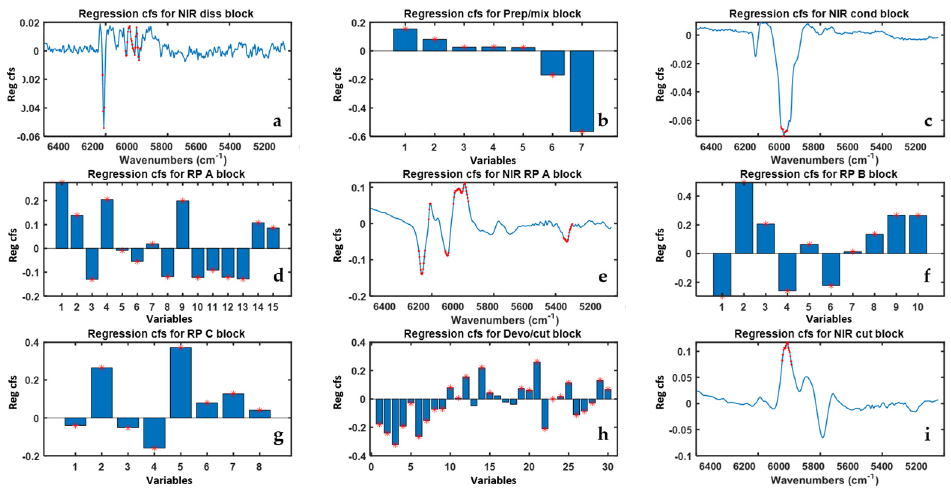
Figure 6. Regression coefficients resulting from the ‘MB-PLS all’ model for each data block the letters ( a – i ) refer to the different block whose name is reported on top. Red stars indicate variables exhibiting VIP scores higher than one.